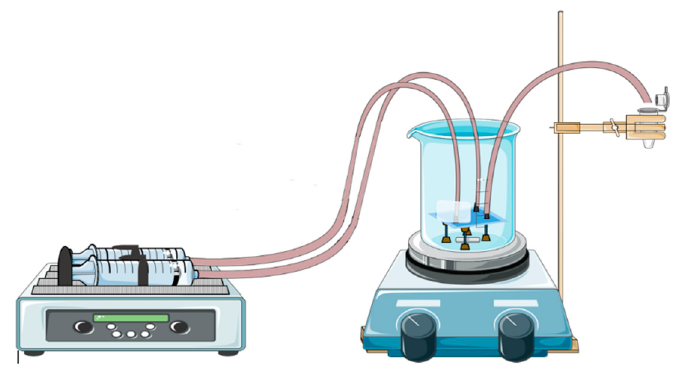
Figure 15. Schematization of operation of LTCC device applied on synthesis of gold nanoparticles and the heating system based on boiling-water bath.